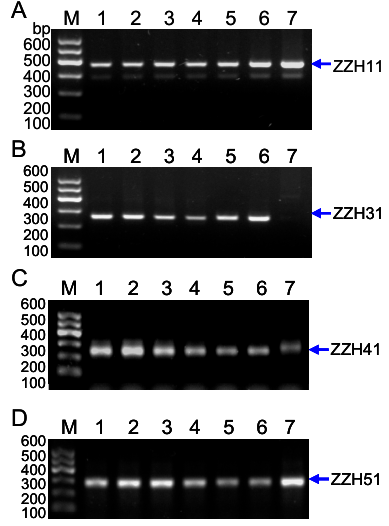
Figure 6. Genetic authentication of Gardenia jasminoides based on ZZH11 ( A ); ZZH31 ( B ); ZZH41 ( C ) and ZZH51 ( D ) SCAR markers. Lanes 1–6 are the DNA samples of G. jasminoides Ellis var. grandiflora Nakai from Jiangxi, Fujian, Guizhou, Sichuan, Hunan and Zhejiang respectively (Table 1). Lane 7 is a sample of G. jasminoides from Luzhou in Sichuan (No. 7 in Table 1). Lane M indicates the DNA molecular weight marker DL600 with the fragment size (bp).